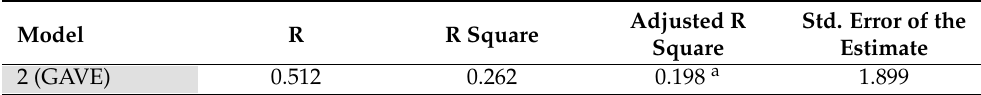
Table 5. Summarized regression analysis of the giving-related explanatory variables of final perfor- mance.